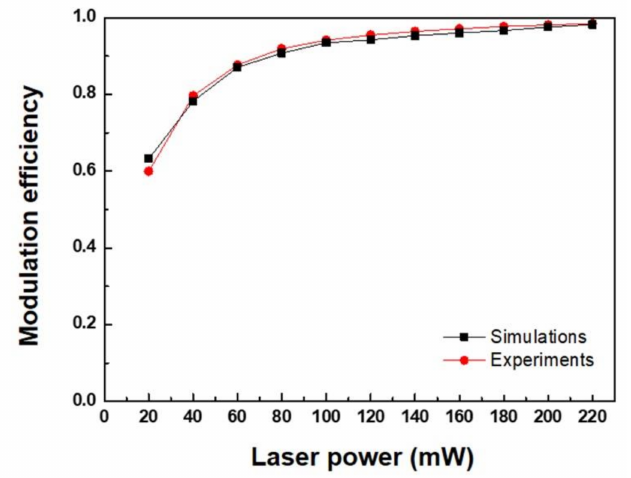
Figure 4. Modulation efficiency of THz wave transmission extracted from the simulations shown in Figure 2a (black squares) and experimental results shown in Figure 2b (red circles), plotted as a function of the laser power of the incident optical beam for